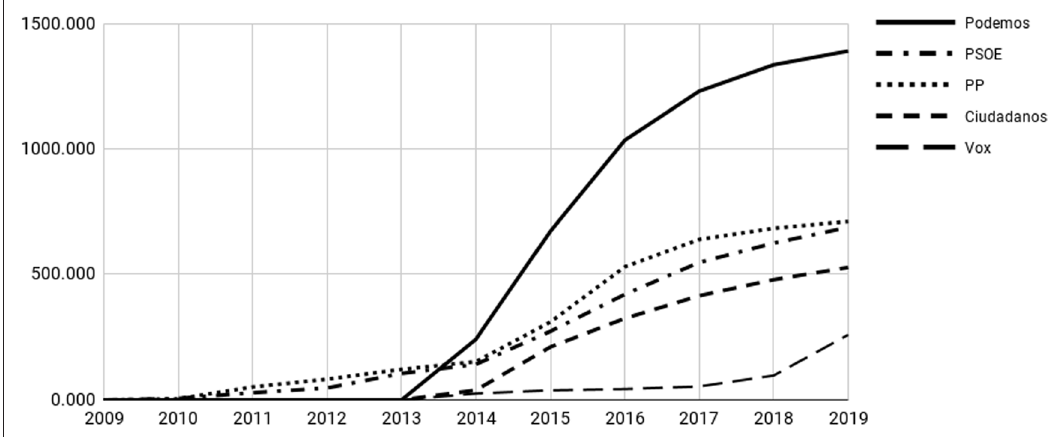
Figure 1: Number of Followers per Account by Year,